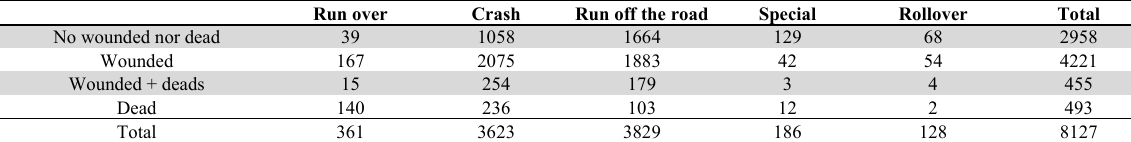
Descriptive statistics between accident severity and accident type Run over